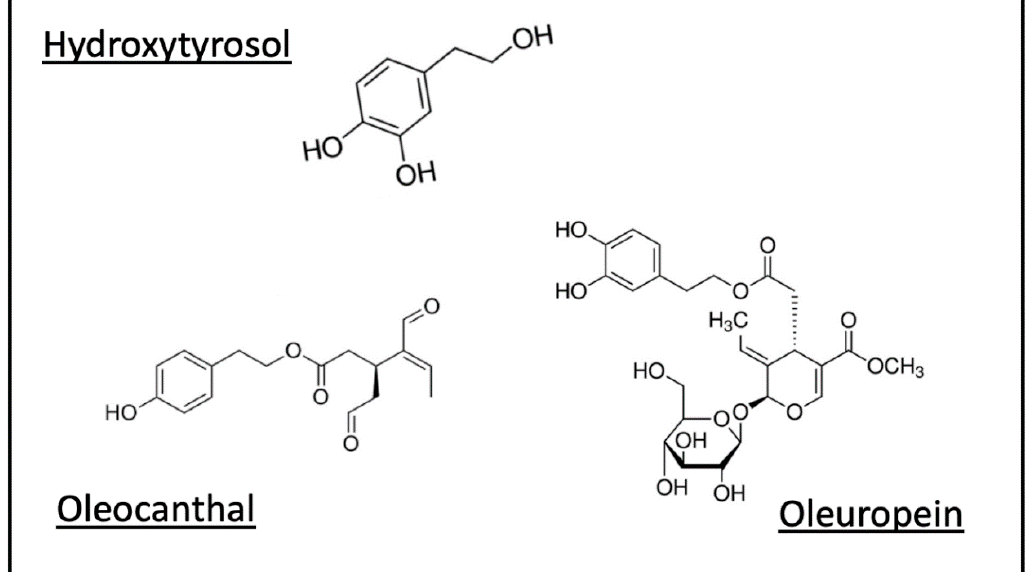
Figure 4. Polyphenols are a family of vegetal compounds characterized by phenol rings as part of their molecular structure. While the family includes a long list of compounds, current data can be found on the health benefits of some, with most available information centered on hydroxytyrosol, oleocanthal and oleuropein.